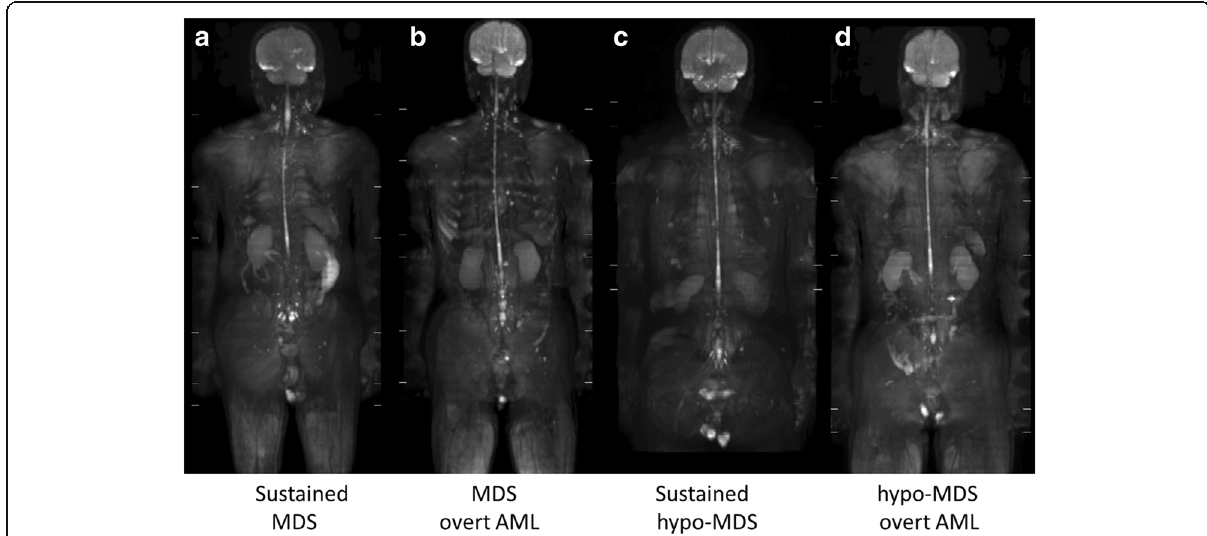
Fig. 7 Maximum intensity projection DWI images of MDS patients ( a – d ). a – d in Fig. 7 are identical to a – d in Fig. 5, respectively. Whole-body DWI did not demonstrate any significant differences in bone marrow signals between MDS and hypo-MDS patients. DWI did not demonstrate any